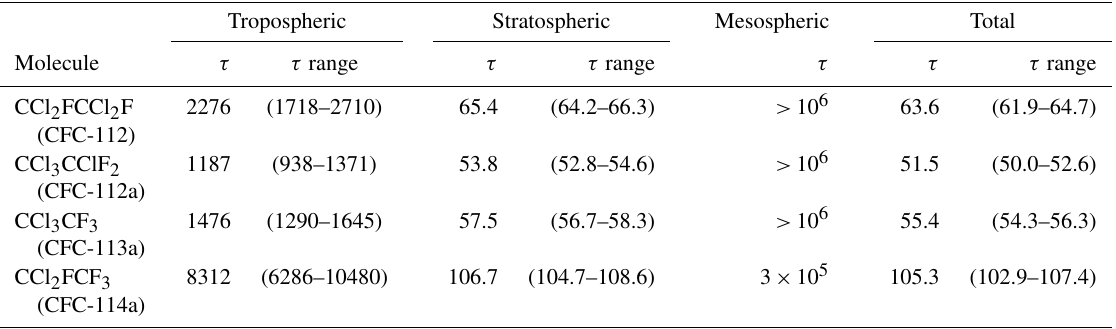
Table 5. Atmospheric lifetimes ( τ) a and ranges b (years) for CCl 2 FCCl 2 F (CFC-112), CCl 3 CClF 2 (CFC-112a), CCl 3 CF 3 (CFC-113a), and